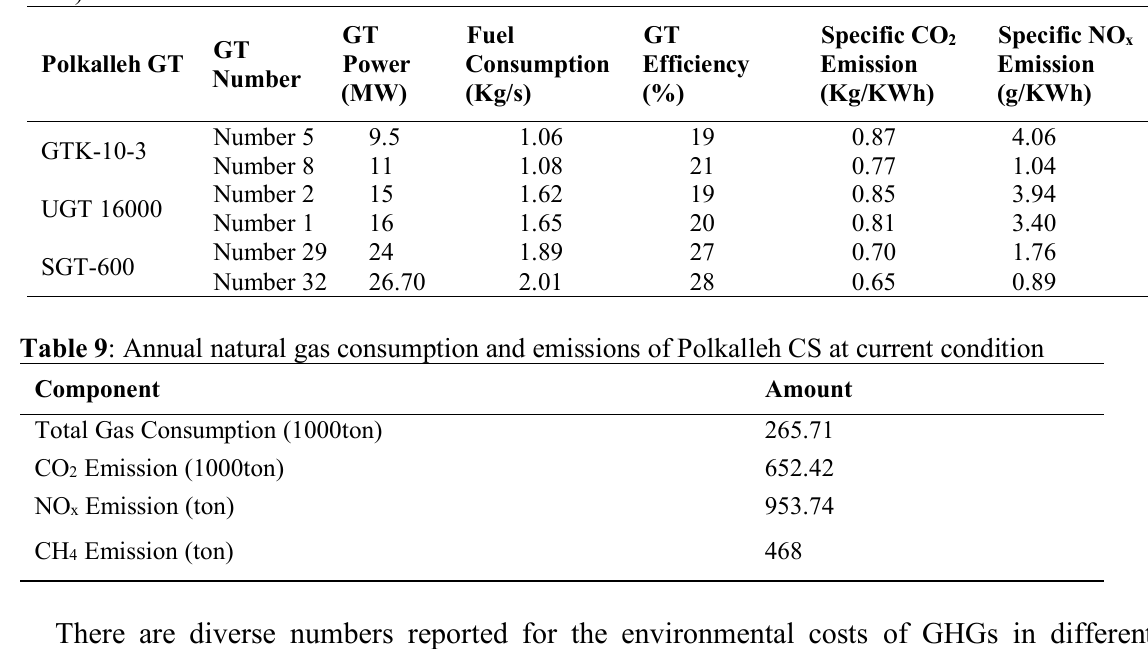
Table 8 . The efficiency of correspondence GTs in Iran to the Polkaleh CS (Shahsavari Alavijeh et al.